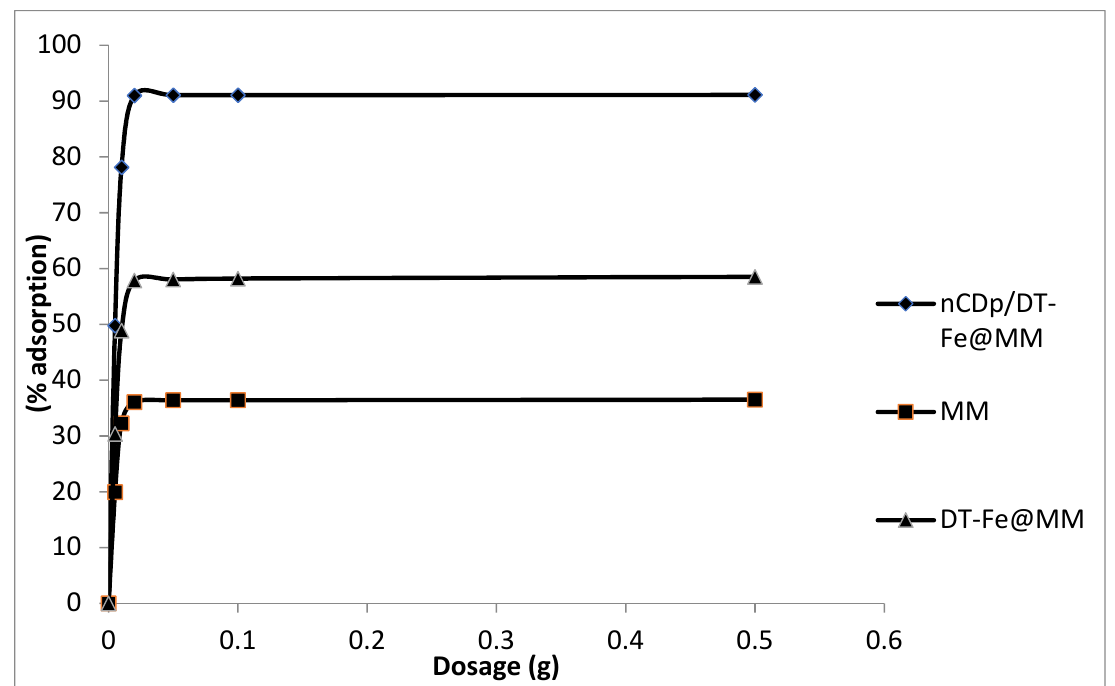
Figure 10. Effect of dosage on the removal of BPA. (Adsorption conditions: C o 50 mg/L; T = 30 °C; t = 120 min; pH = 7).